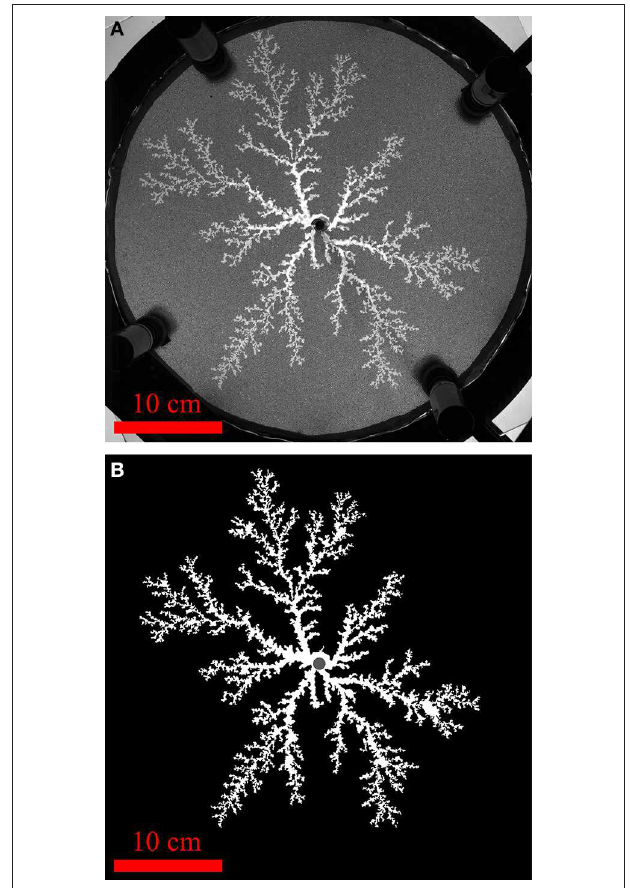
FIGURE 2 | The raw data breakthrough image of the confined deformable experiment with 75 hPa injection pressure (A), and the resulting binary image after segmentation of the air cluster (B), where the active pixels belonging to the cluster is shown in white and the inactive background pixels are shown in black. The dark injection region where it is difficult to separate saturated and invaded parts is indicated in gray, and is excluded from our analysis. In the raw data image we can also see the 0.5 cm thick semi-permeable belt surrounding the porous